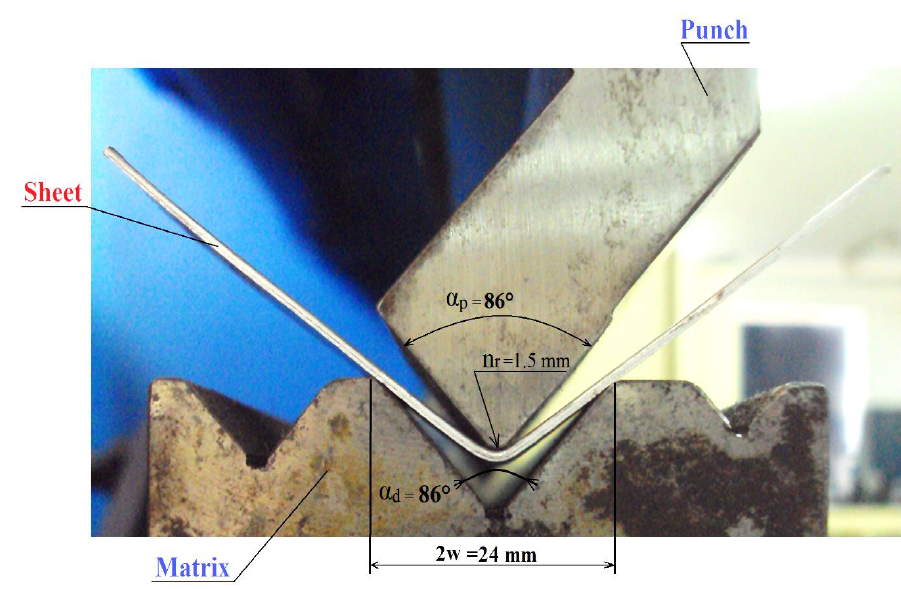
Fig. 6. Experimental matrix and